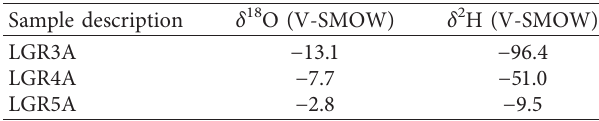
Table 1: Standard samples of different specifications (‰). Sample